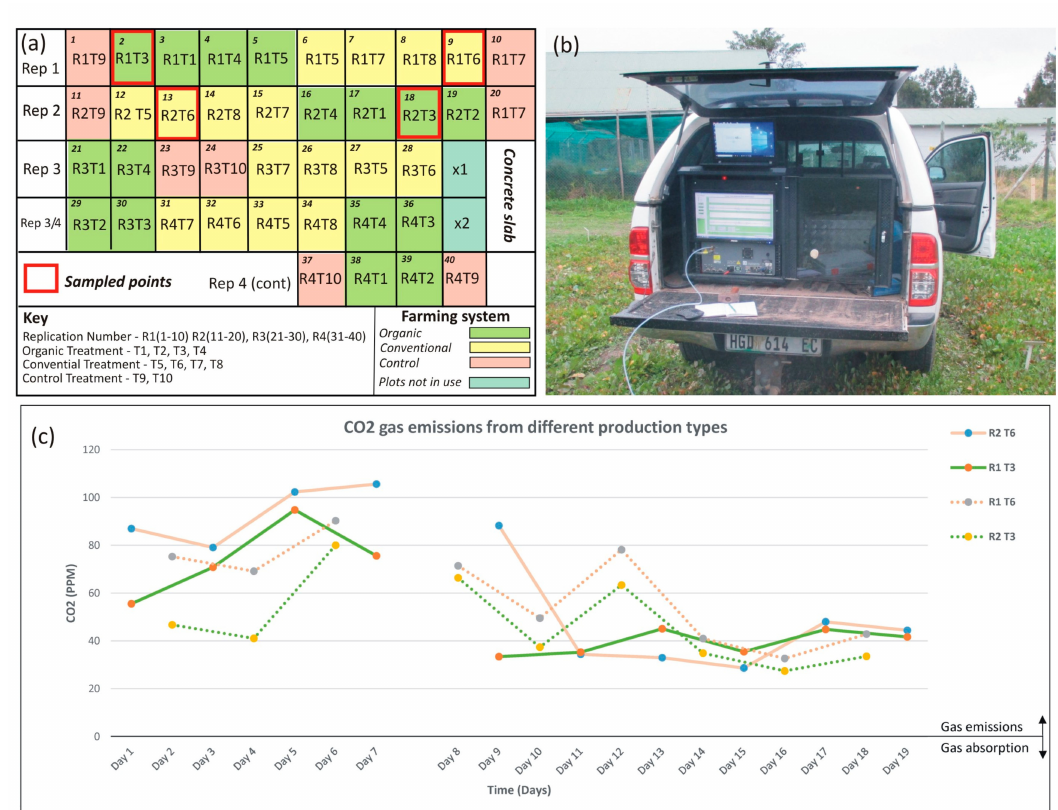
Figure 11. Comparative study of CO2 emissions between conventional and organically-farmed soils: ( a ) Farming system showing the four sampled plots; organic and conventional plots are sampled on the same day and at the same time. ( b ) Picarro G2201-I gas analyzer used in this study; and ( c ) CO2 emissions (in ppm) measured in July and August 2018; first seven days were during dry soils, and last eleven days was during moist soils following rainfall. Results revealed that conventional farming emit more CO2 than organically-farmed soils, and that soil respiration and emission are inhibited by high moisture content. Similar measurements of CH4 were also included (not shown